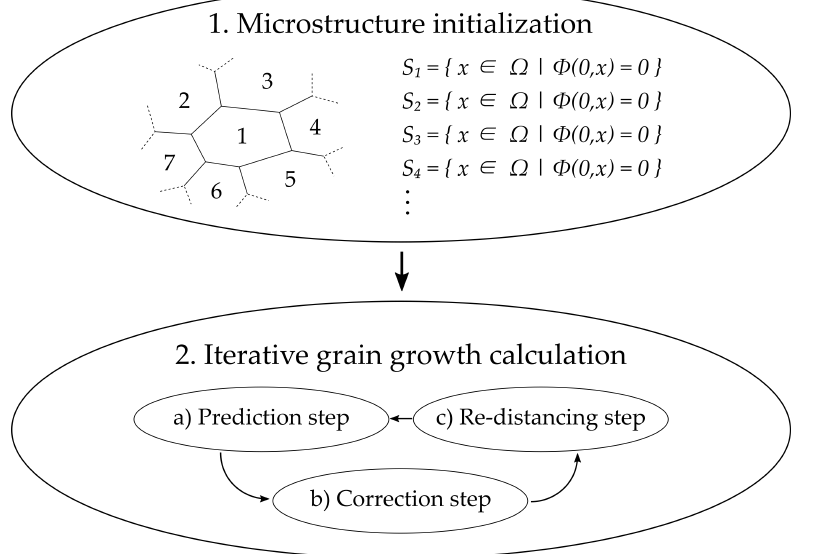
Figure 9. Flow chart showing the main steps of the level-set